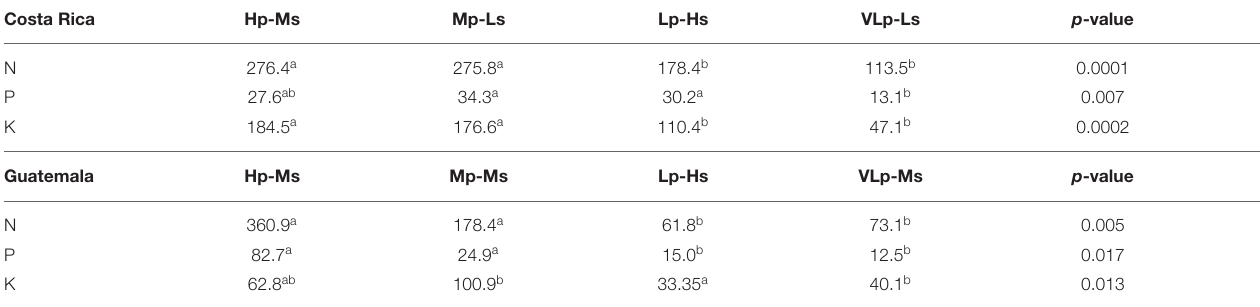
TABLE 4 | Median nutrient input levels (kg ha − 1 yr − 1 ) for each coffee plantation typology (key to typology codes in Table 2